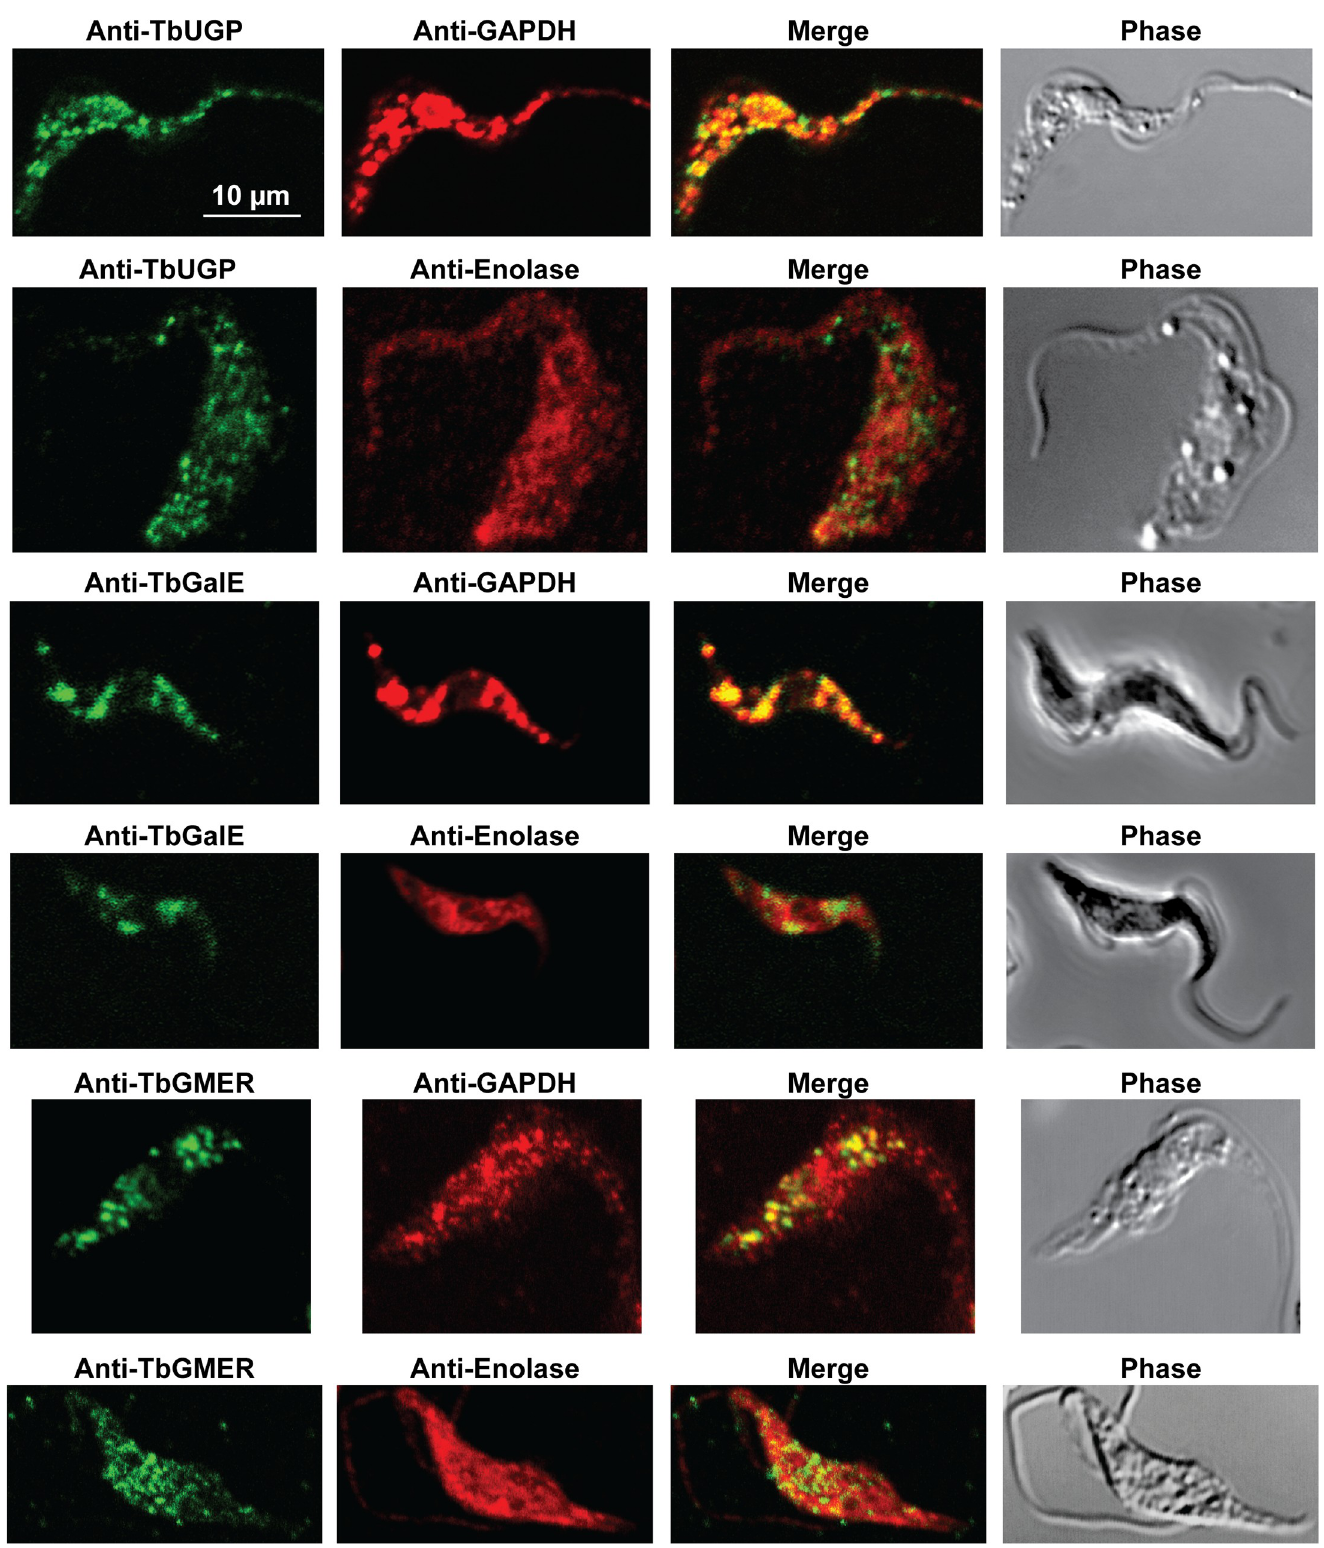
Fig 4. Immunofluorescence microscopy localisation of UDP-Glc, UDP-Gal and GDP-Fuc biosynthetic enzymes in procyclic form T . brucei . Enzymes of UDP-Glc, UDP-Gal and GDP-Fuc biosynthesis were localised with mono-specific mouse antibodies (green channels). Authentic glycosome and cytosol